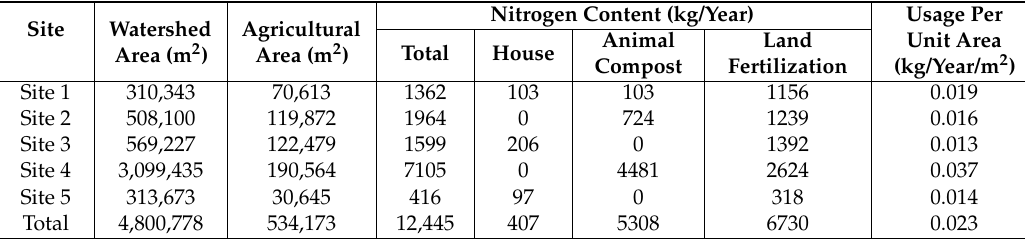
Table 11. Pollution loading results of high-pollution areas.